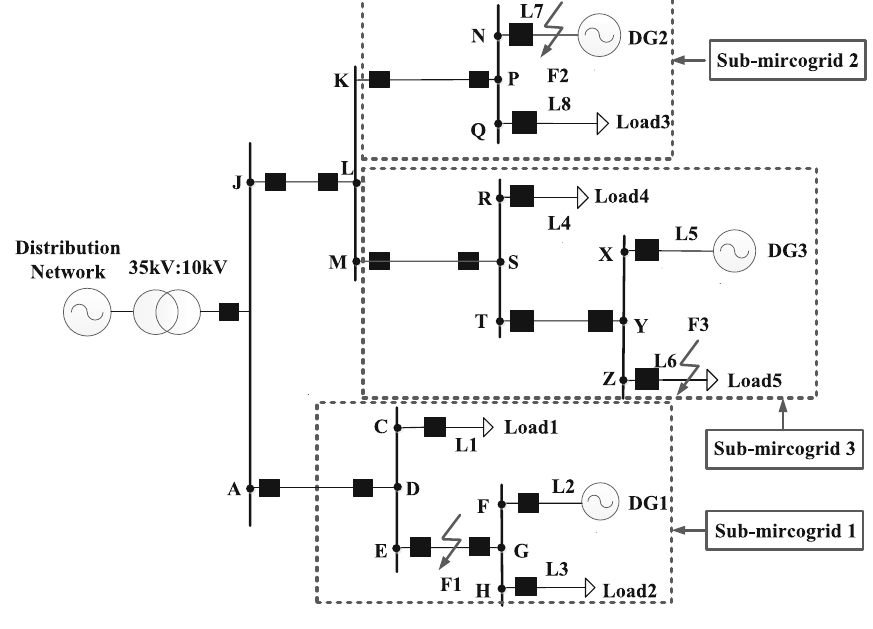
Fig. 9 Simulation model of the